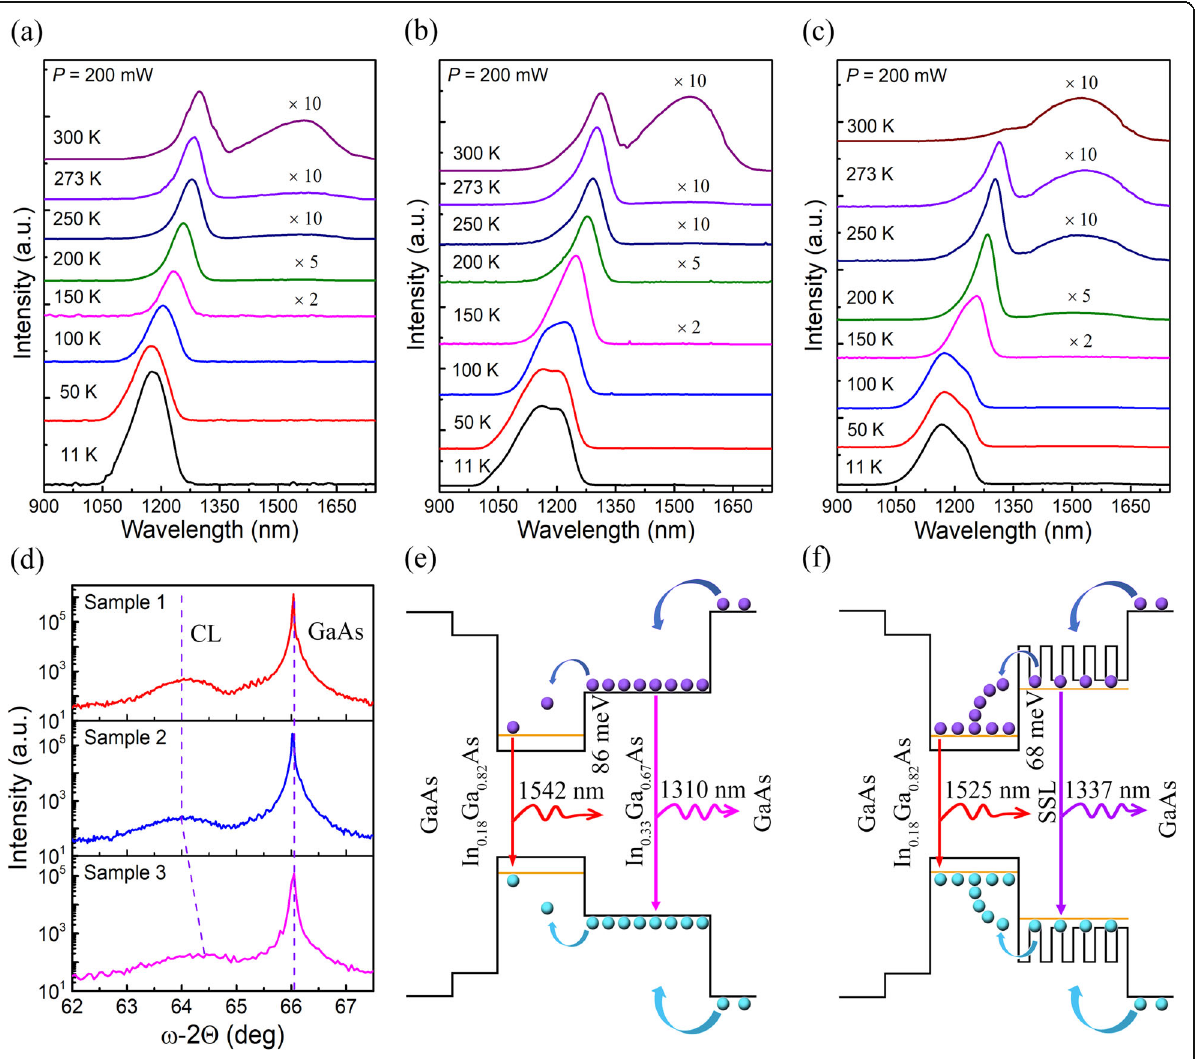
Fig. 2 Material characterization and schematic band diagram. PL spectra measured at 11-300 K from a sample 1, b sample 2, and c sample 3, respectively. d High-resolution ω /2 θ scans showing the GaAs (008) substrate peak and CL diffraction pattern for samples 1, 2, and 3, respectively. Schematic band diagram for e sample 2 and f sample 3,